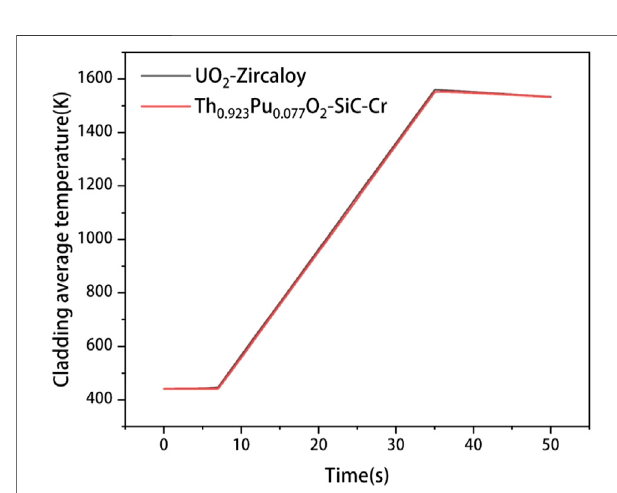
FIGURE 18 | Average temperature of Zircaloy cladding and Cr-coated SiC/SiC composite